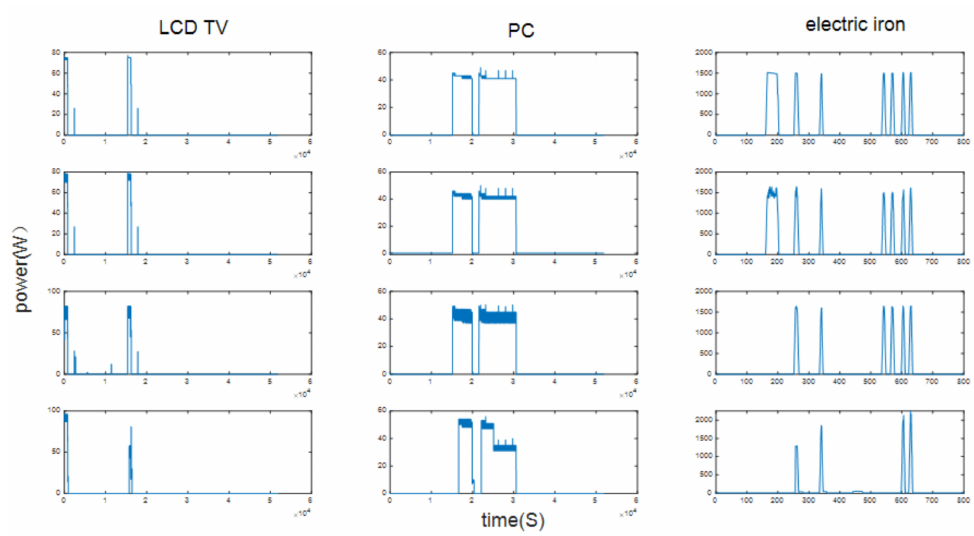
Figure 8. Identification Results of the three devices in TraceBase. (Line 1: the actual power curve of the load; Line 2: the load identification result based on the improved dAE algorithm; Line 3: the load identification result based on the standard dAE algorithm; Line 4: the load identification result based on the FHMM algorithm).